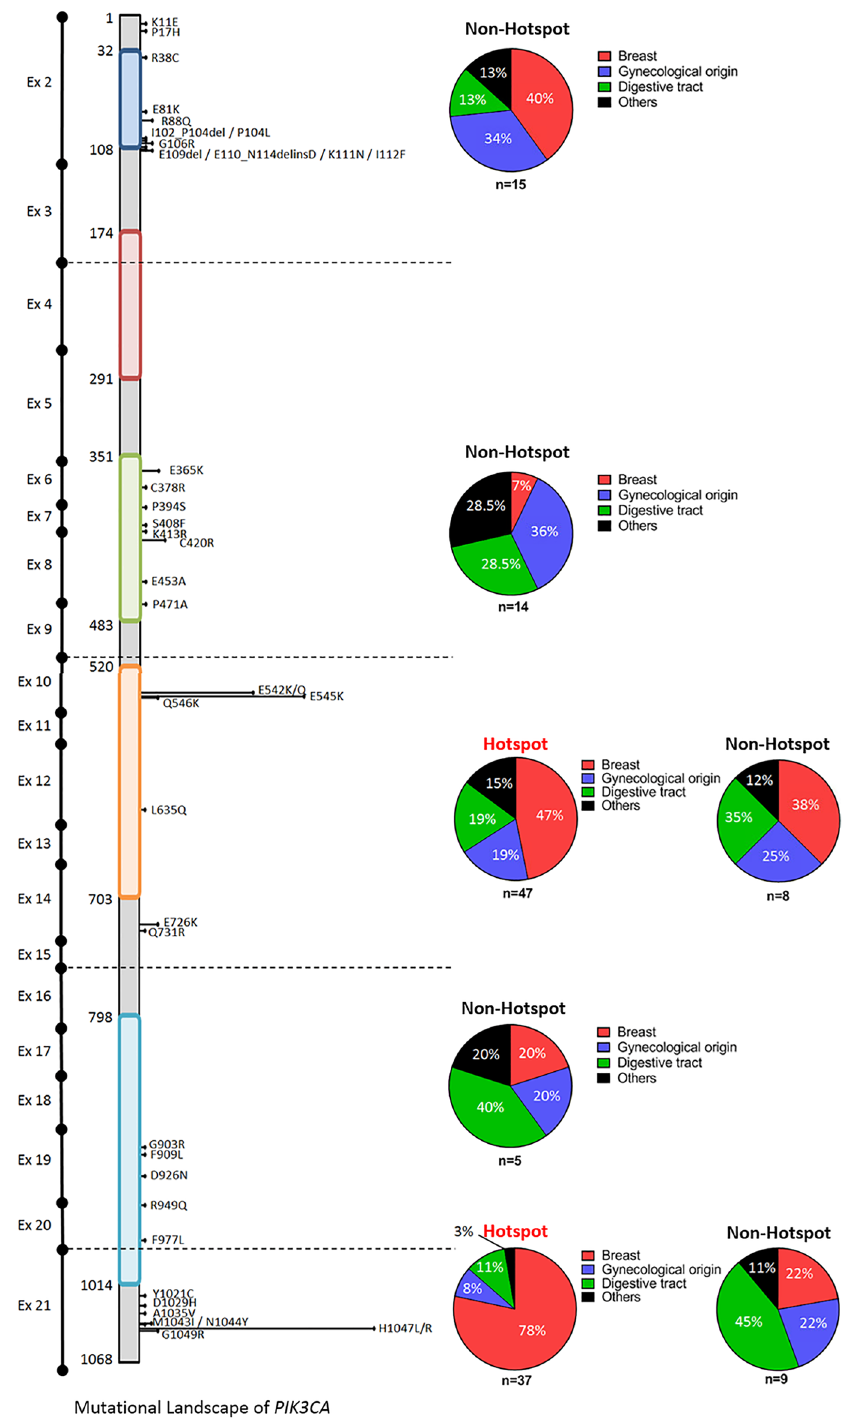
Figure 2. Mutational landscape of PIK3CA